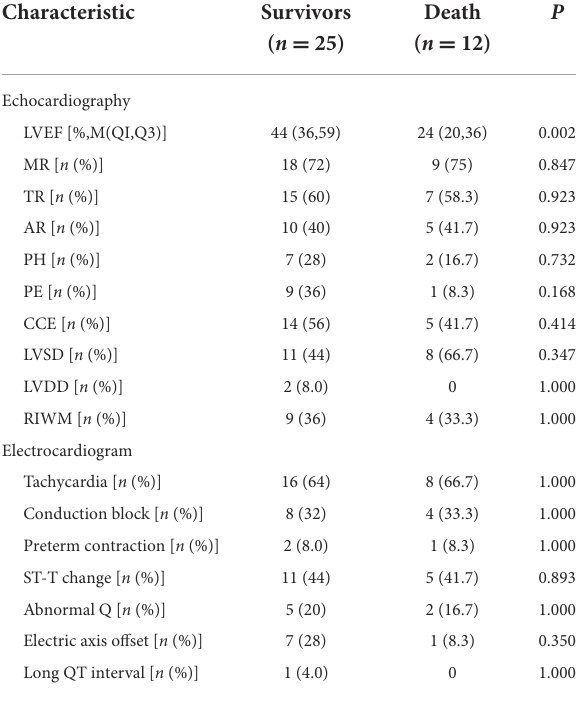
TABLE 3 Comparison of ECHO and ECG of children with FM.